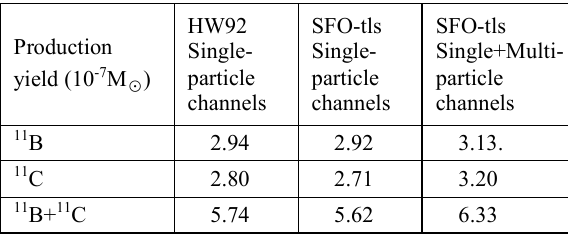
Fig. 3. Calculated partial cross sections for 16 O (ν e , e － X ), with X = p, pp, 3 He, α, αp, via excitations of 2 － states in 16 F obtained by shell-model calculation with the SFO-tls. (Taken from Ref. [18]) Table 1. Production yields of 11 B and 11 C in supernova explosion for progenitor mass of M=15M ☉ . Here, “single- particle channels” denotes γ, p, n and α emission